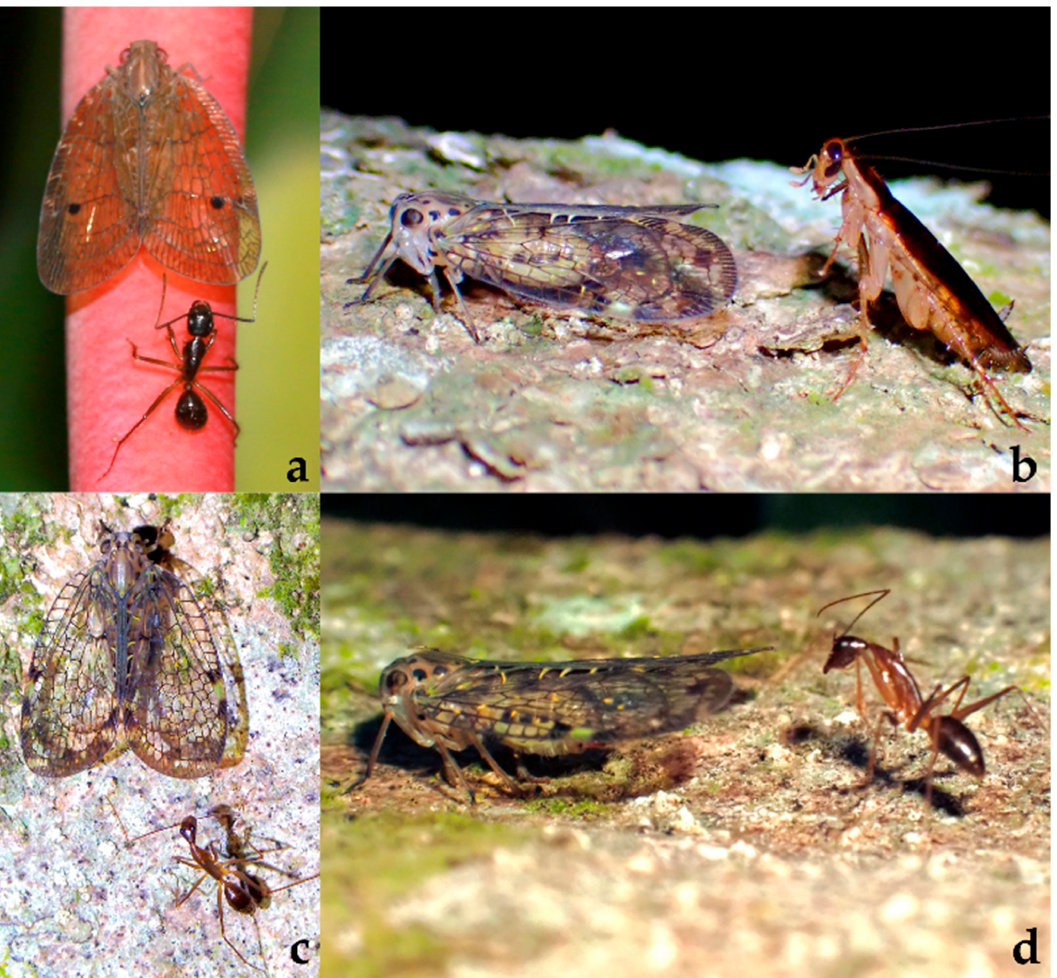
Figure 23. Nogodinidae: ( a ) Biolleyana fenestra (Gerstaecker, 1895) tended by Formicidae: Formicinae: Camponotus sp., Costa Rica: Rio Agujitas River, 8°41 ′ 27.9 ″ N 83°40 ′ 42.7 ″ W, 02.04.2018, adult on tree trunk, obs. T. Stice; ( b ) Paravarcia sp. tended by Blattodea indet., Malaysia: Penang Island, 5°25 ′ 28 ″ N 100°16 ′ 08.1 ″ E, 20.01.2021, adult on unidentified tree trunk, obs. A. Kang; ( c , d ) Paravarcia sp. tended by Formicidae indet., Malaysia: Penang Island, 5°25 ′ 28 ″ N 100°16 ′ 08.1 ″ E, 30.11.2020, adult on unidentified tree trunk, obs. A. Kang.